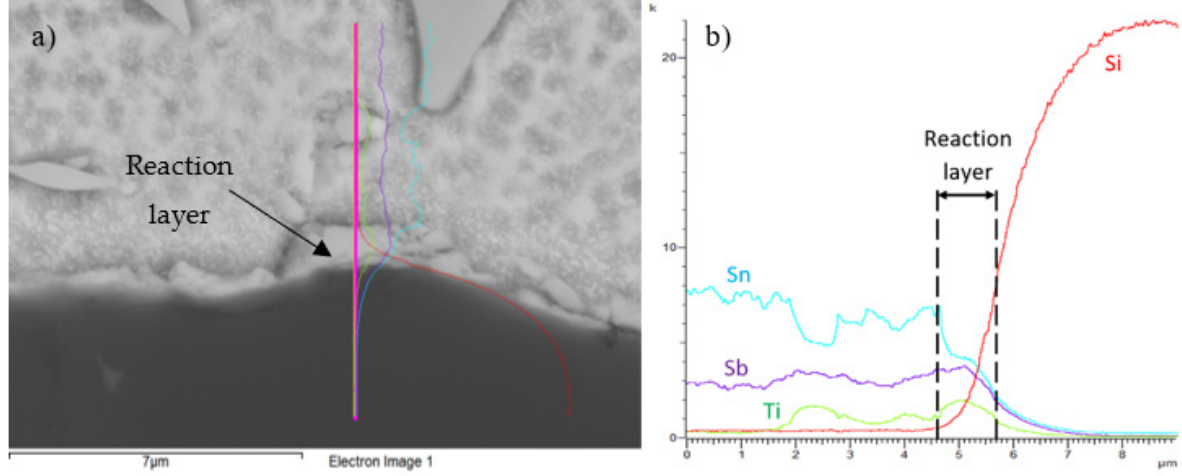
Figure 20. Line EDX analysis of the SiC/Sn5Sb3Ti joint; ( a ) transition zone with a marked line; ( b ) concentration profiles of Sb, Sn, Ti, and Si elements .